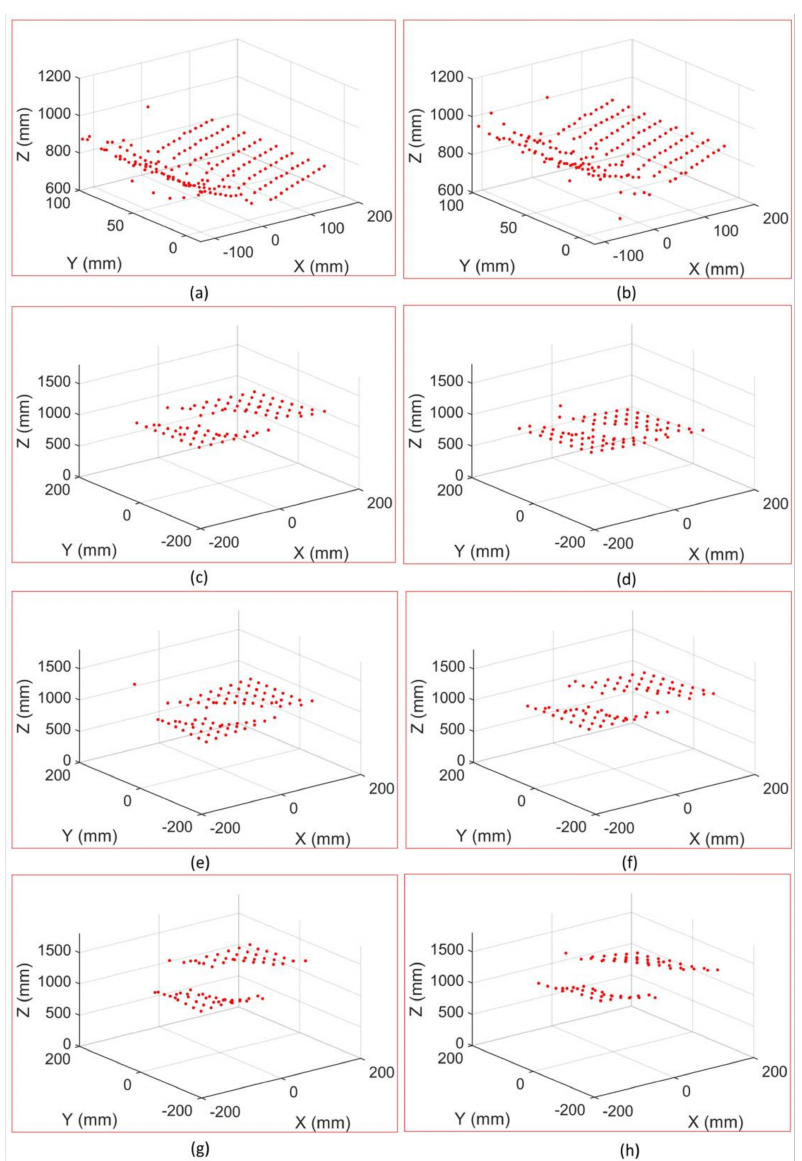
Figure 15. Constructed 3D points for images ( a – h ) in Figures 13 and